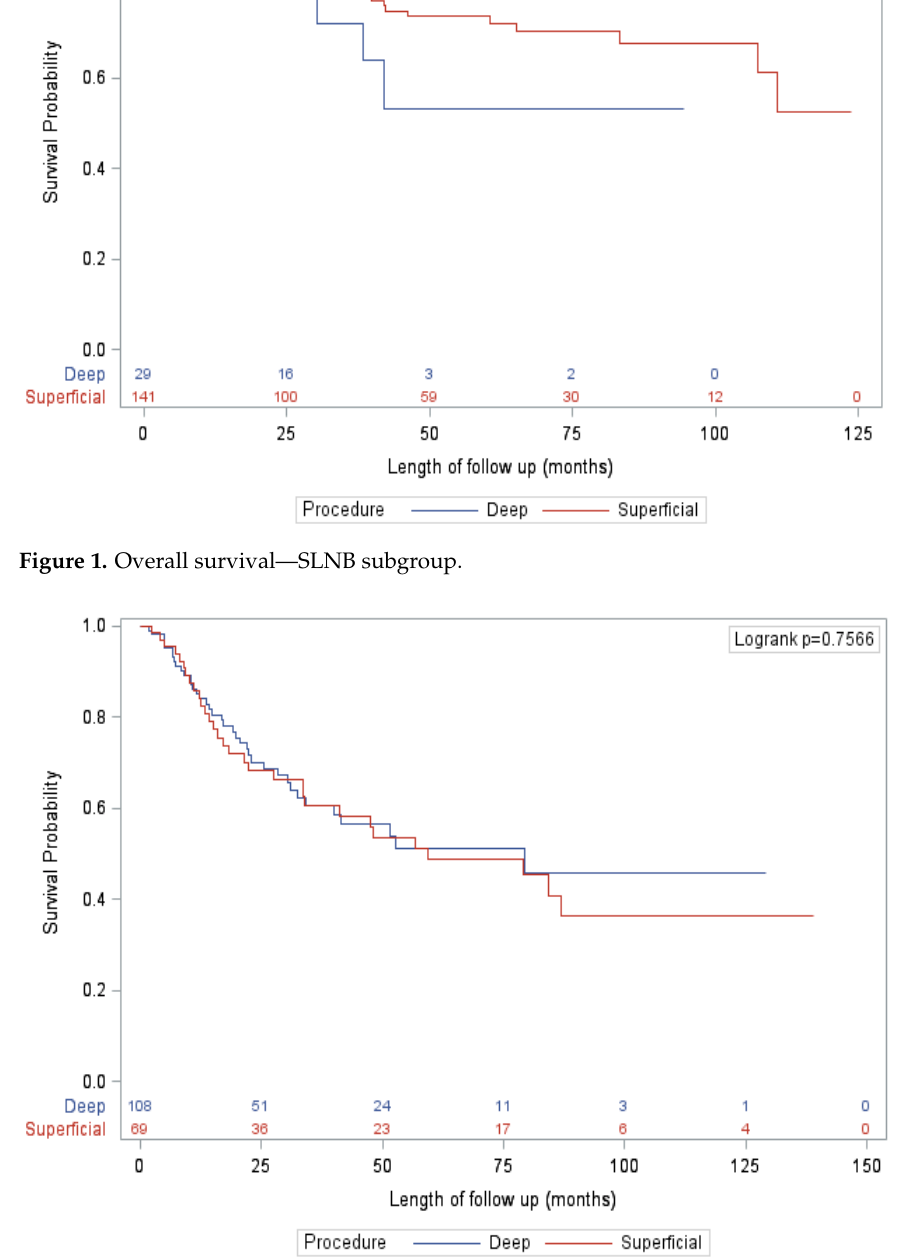
Figure 2. Overall survival—palpable/imaging subgroup.